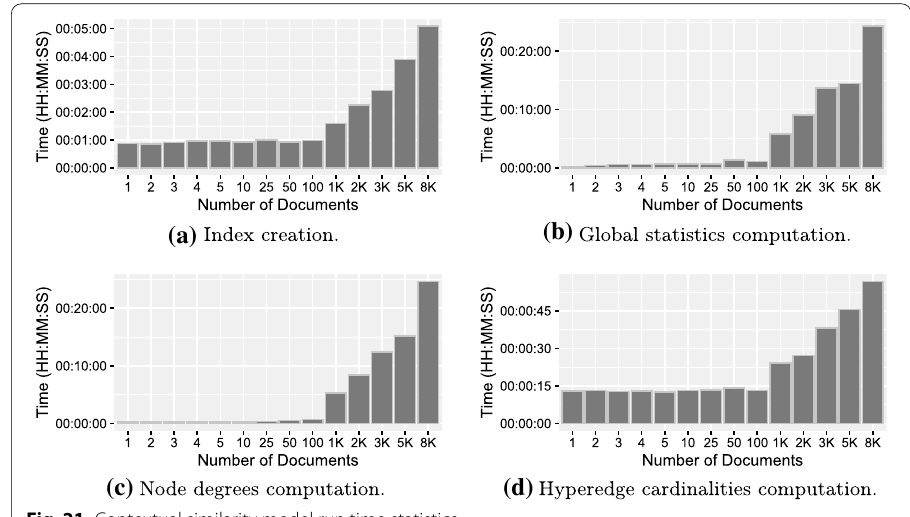
Fig. 21 Contextual similarity model run time